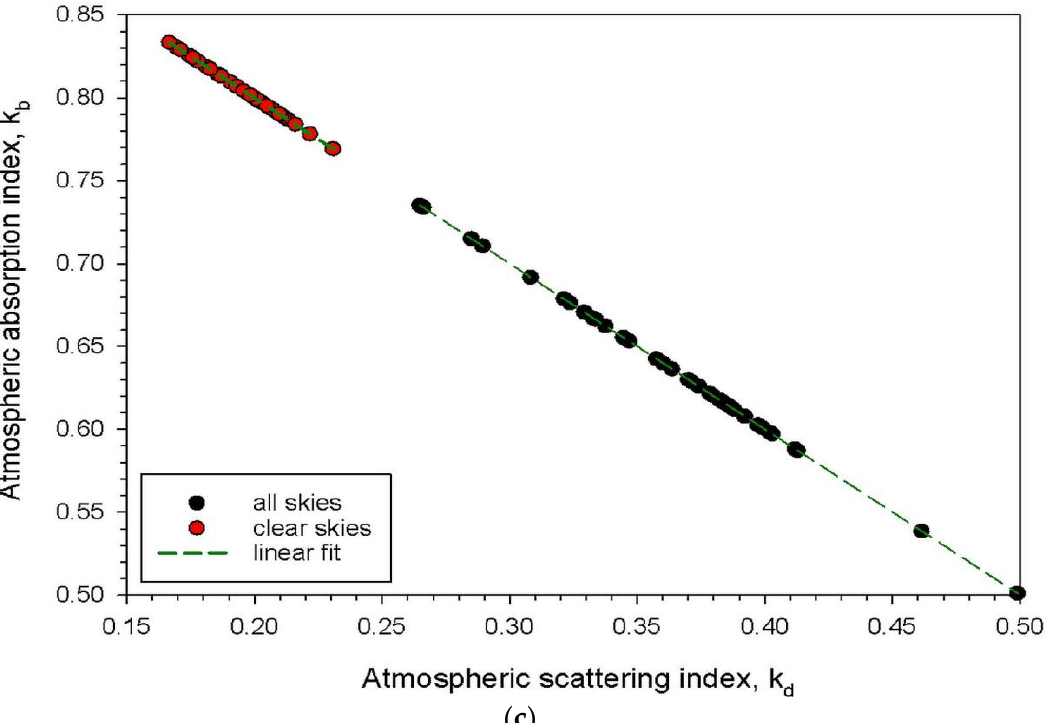
Figure 10. Scatter plot of the annual mean values of the atmospheric scattering index, k d , and the atmospheric absorption index, k b , as a function of their geographical latitude, ϕ , under ( a ) all-, and ( b ) clear-sky conditions over Saudi Arabia in the period 2013–2021. The straight lines are linear fits to the k d (solid line) and k b (dashed line) data points, with expressions: ( a ) k d = − 0.0064 ϕ + 0.5182, with RMSE = 0.0416, MAE = 0.0350, d = 0.5660, r = 0.4827, and R 2 = 0.2330; and k b = − 0.0069 ϕ + 0.4711, with RMSE = 0.0416, MAE = 0.0350, d = 0.5830, r = 0.5093, and R 2 = 0.2594; and ( b ) k d = − 0.0020 ϕ + 0.2441, with RMSE = 0.0127, MAE = 0.0112, d = 0.5690, r = 0.4858, and R 2 = 0.2713; and k b = 0.0020 ϕ + 0.7559, with RMSE = 0.0127, MAE = 0.0111, d = 0.5690, r = 0.5211, and R 2 = 0.2715. By adding the regression functions side-by-side in both cases, one obtains the basic equation k d + k b = 1. ( c ) A plot of the annual mean values of k b vs. k d under all- and clear-sky conditions and over all sites in the period 2013–2021; the linear fit to the data points is the basic equation k b = 1 − k d . The plots were made with the SYSTAT’s SigmaPlot 14.0.0.124 graphing software, and the statistical results were computed with the MICROSOFT’s Excel 2021 functions. Bai and Zong [43], in an effort to develop a solar radiation model to estimate G for the Qianyanzhou area, China, as a sum of absorbing and scattering losses in the atmosphere, observed that: (i) the absorbing losses (expressed as percentage of their R LA factor for k d ≥ 0.80 under all-sky conditions and k d < 0.80 under clear-sky conditions; Table 3 in their publication) were higher in spring and winter (in agreement with the solid black line in Figure 11b in the present study, showing lower k b values in all-sky conditions, but in relative disagreement with the dashed black line in Figure 11b showing higher values in clear skies); (ii) the scattering losses (expressed as percentage of their R LS factor for all-sky conditions; Table 3 in their publication) were higher in summer and autumn (in agreement with the solid line in Figure 11a in the present study showing lower k d values) and higher in spring and winter under clear skies (in comparison with the dashed black line in Figure 11a in the present study). The slight disagreement between the findings in [43] and those of the present study for clear skies may be due to year-round variations in atmospheric aerosols (concentration and type) between China and Saudi